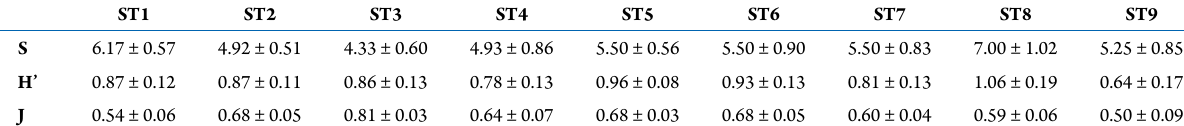
Table 5. Biological indices (Mean ± SE) at the stations (S: species richness; H’: Shannon’s diversity; J: Pielou’s evenness).